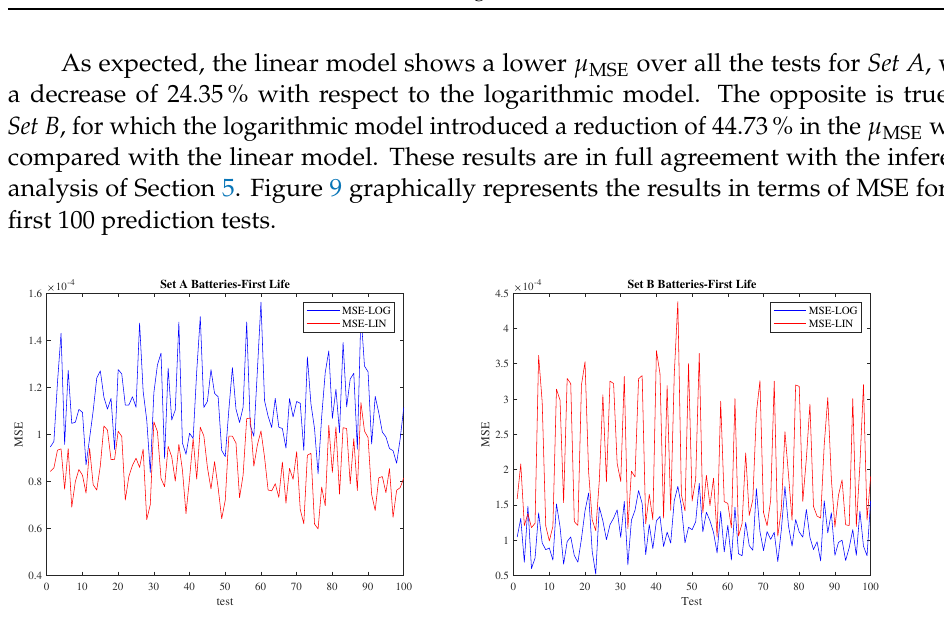
Figure 9. First life prediction results for 100 random splits of data